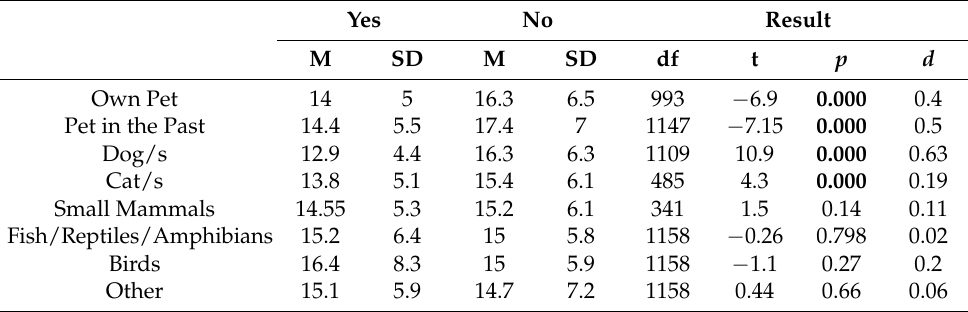
Table 4. Results from t -tests examining differences in attachment scores for pet